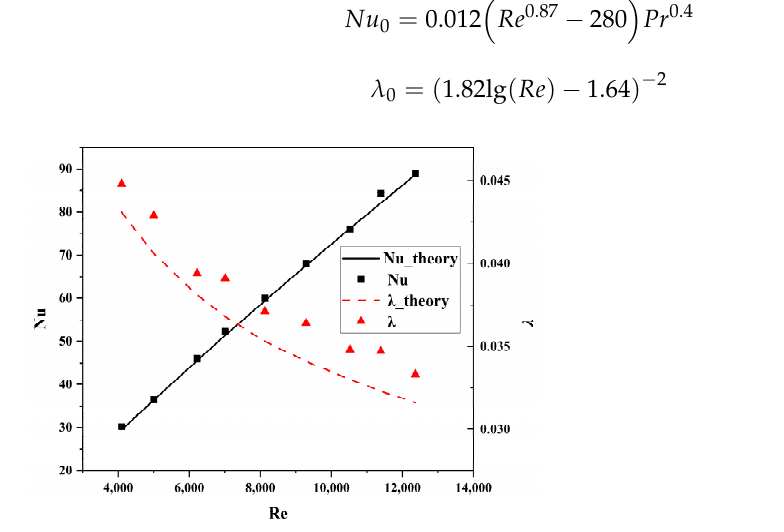
Figure 5. Model validation for performances of heat transfer and flow in the plain tube